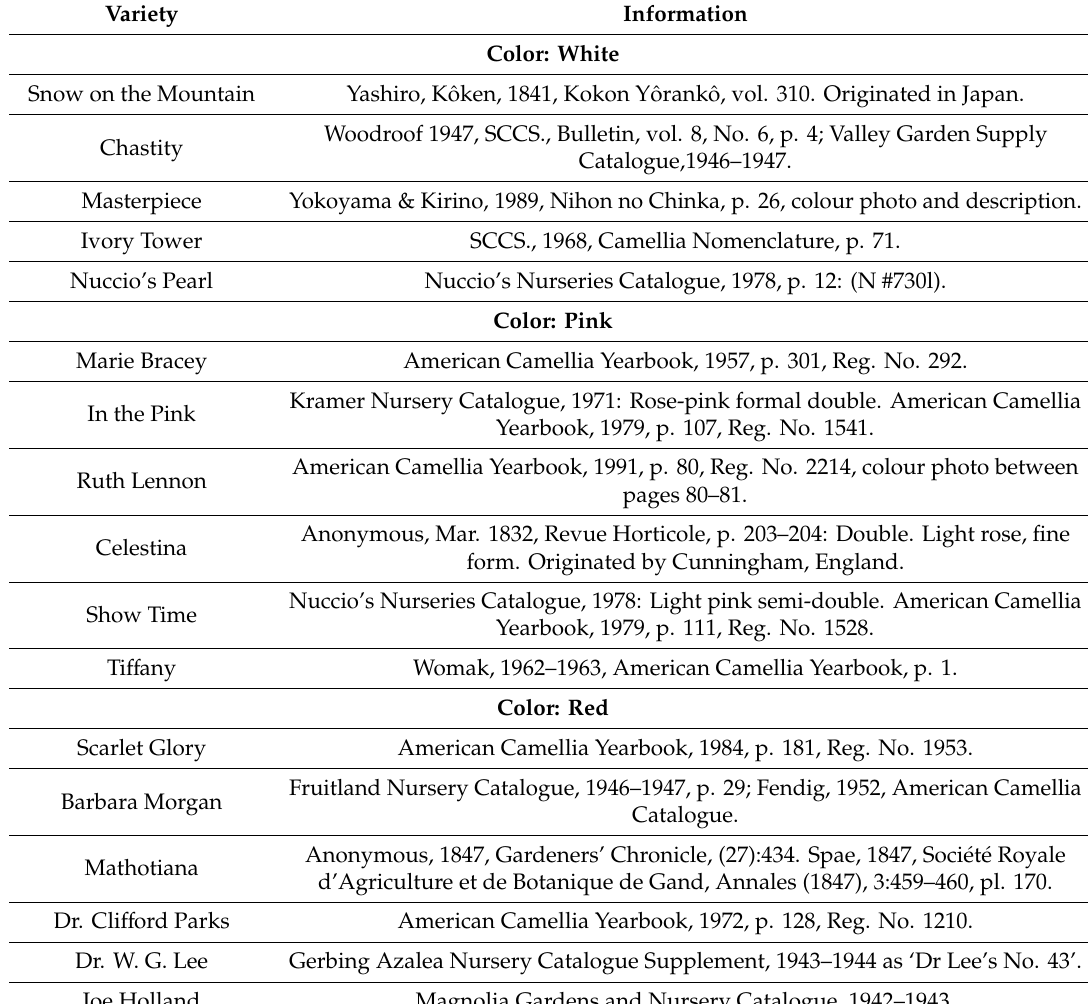
Figure 3. Example of measuring camellia petal color using: ( a ) the Royal Horticultural Society (RHS) Colour Chart [10], and ( b ) the Nix TM Pro color sensor [11]. Table 1. Sampled camellia ( Camellia japonica L.) in the South Carolina Botanical Garden with information from the International Camellia Society (2020) [22].